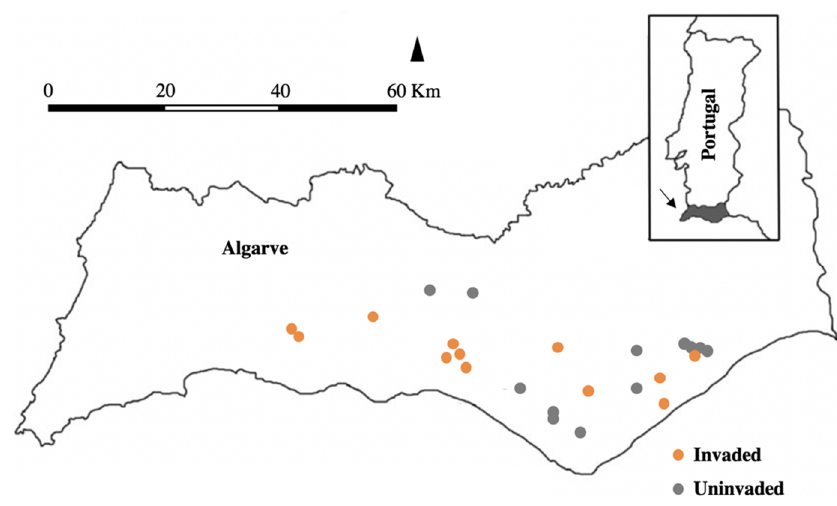
Figure 1. Map of the Algarve region with the invasion status of sampled orchards. The orange dots represent the invaded orchards by the Argentine ant, while grey dots represent uninvaded orchards.